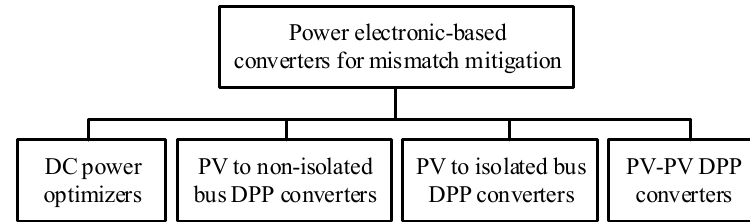
Figure 2. Power electronic-based mismatch mitigation solutions.